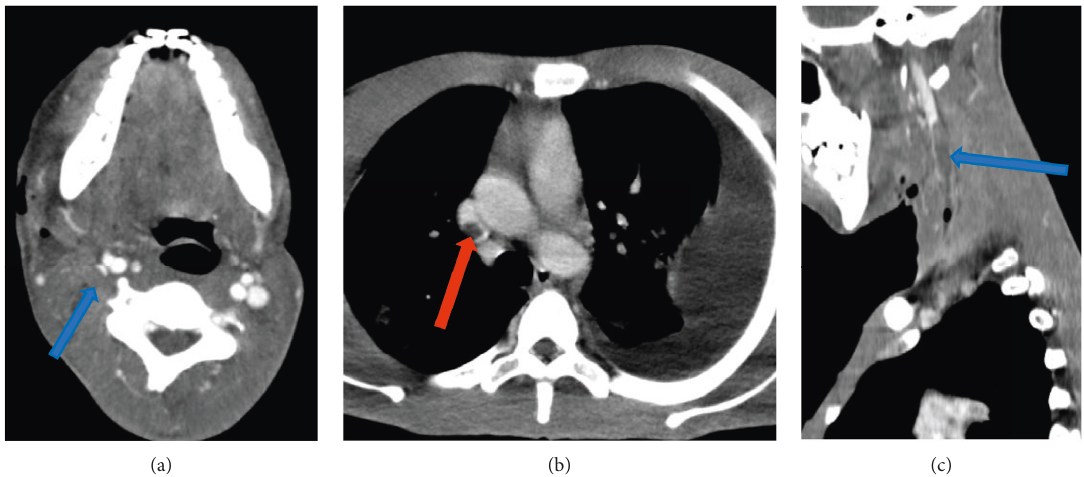
Figure 3: Cervicothoracic CTscan with contrast injection. (a) Axial view at cervical level showing occlusive thrombosis of the right jugular vein (blue arrow). (b) Axial view at thoracic level showing thrombosis of the right superior vena cava (red arrow). (c) Sagittal view showing the thrombosis extended along the right jugular vein to the superior vena cava (blue